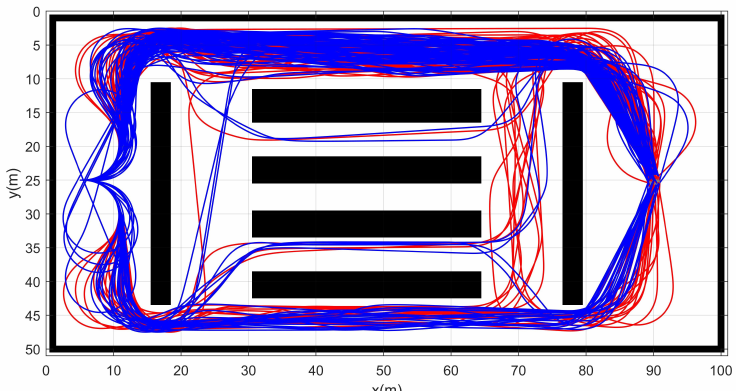
Figure 15. Resultant trajectories from simulation 7. Red lines: DT-RRT, Blue lines: